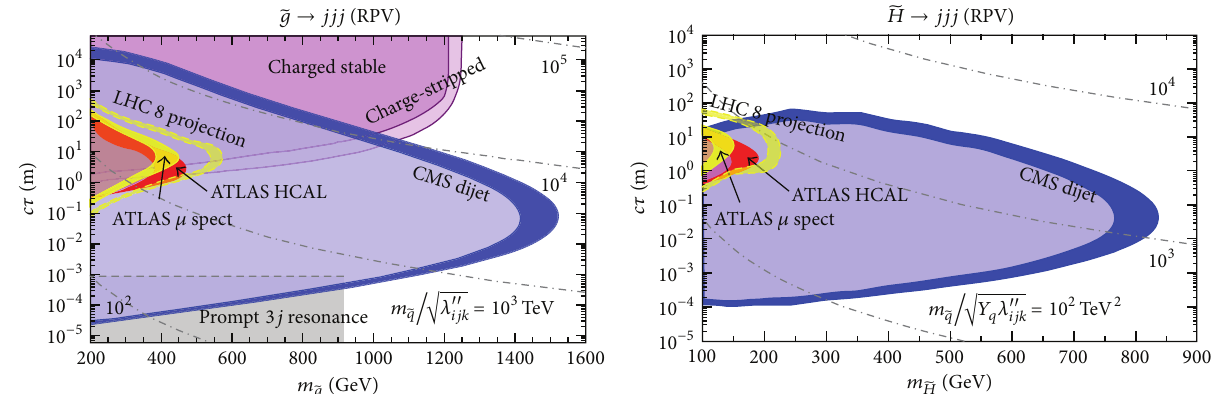
Figure 11: Limits on baryonic RPV from displaced jets searches [16] recast in [19]. For each type of search, a colored area indicated the excluded region in the plane lifetime-mass of the metastable new state. The gray area corresponds to the exclusion from searches for prompt (i.e., nondisplaced) new physics, which is substantially weaker than what can be achieved by most displaced searches. For each color, the darker band represents the uncertainty on the excluded area that comes from varying the reconstruction efficiency for displaced objects.